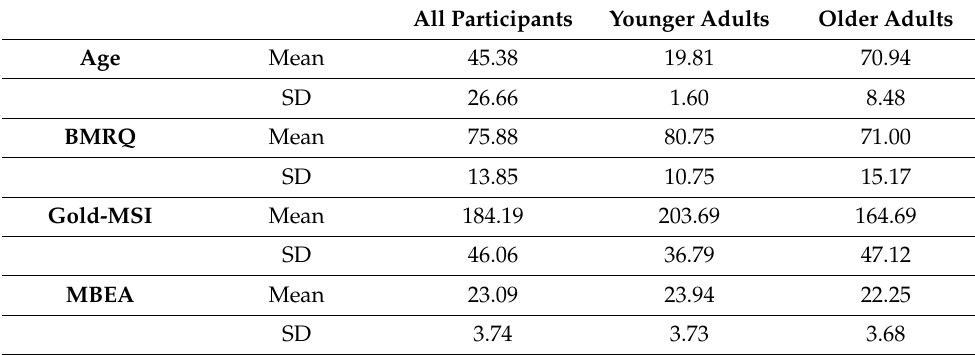
Table 2. Younger and older adults’ mean values and standard deviations (SD) for age (years), the total score of the Barcelona Music Reward Questionnaire (BMRQ), the total score of the Goldsmiths Musical Sophistication Index (Gold-MSI), and scores on the melodic contour perception task from the Montreal Battery of Evaluation of Amusia (MBEA).